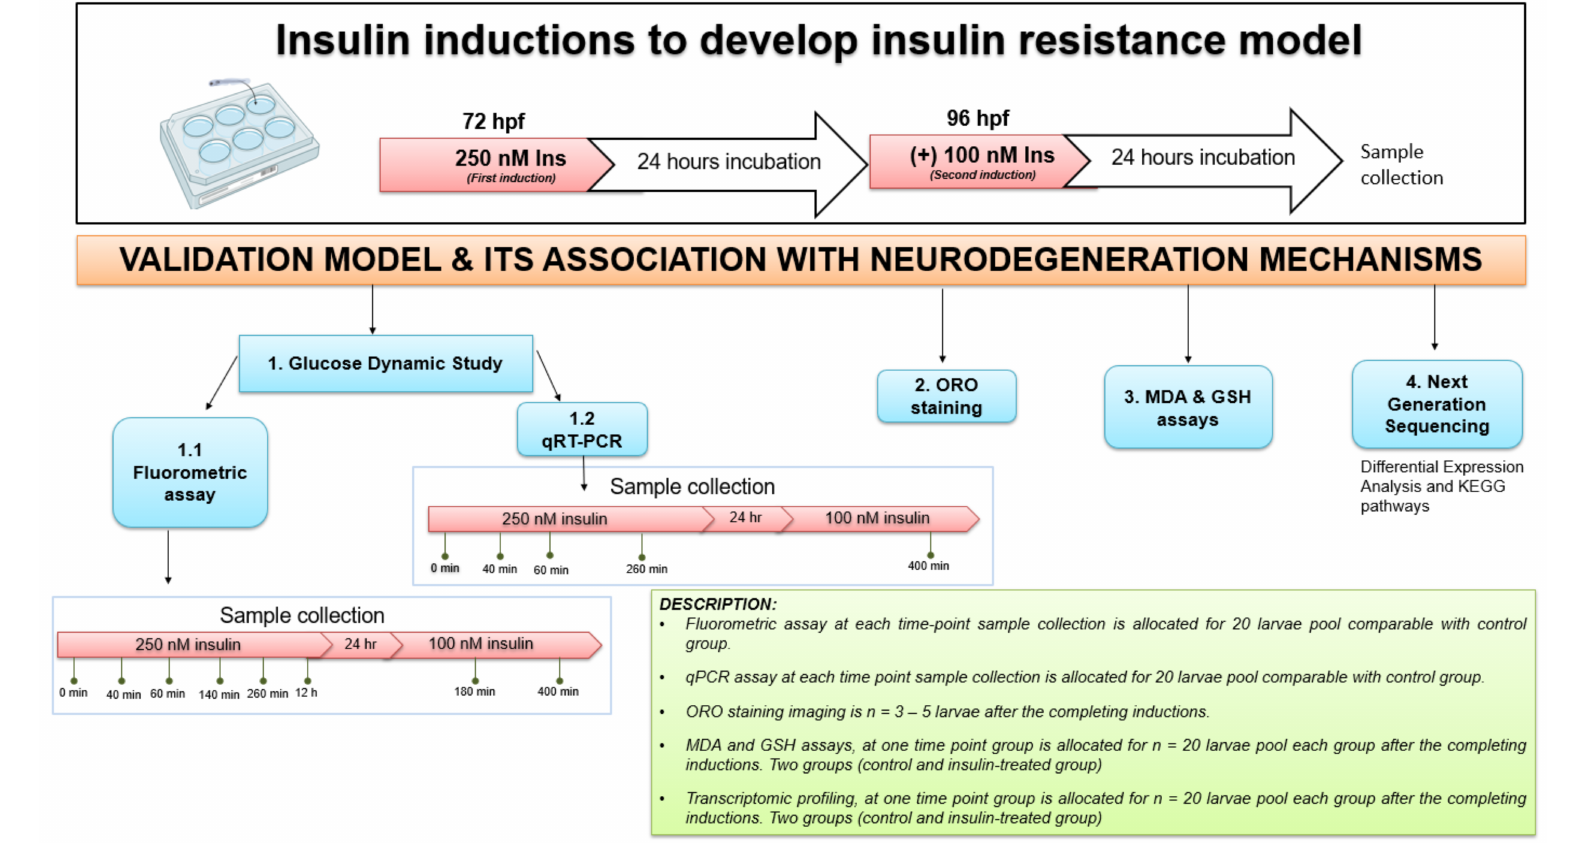
Figure 6. The experimental design for insulin resistance zebrafish larvae model at 72 and 96 hpf with 250 nM and 100 nM insulin induction, respectively, by immersion technique. The groups at each time point were assessed in triplicate ( n = 3). The variation in sampling timing after insulin immersion is revealed. Dynamic glucose assay samples for post-insulin immersion were collected at 0 min, 40 min, 60 min, 140 min, 260 min and 12 h at first induction of 250 nM insulin. After the second insulin induction of 100 nM insulin, samples were taken at 180 and 400 min. Quantitative RT-PCR (qRT-PCR) analysis samples were collected at 40, 60 and 260 min of 250 nM insulin induction and at 400 min of 100 nM insulin induction. After each insulin induction, the ORO staining was scored at 96 hpf and 120 hpf after the first and second insulin induction. MDA, GSH and next-generation sequencing (NGS) for transcriptome profiling were developed to connect to the mechanisms of neurodegeneration. The control used was E3 medium containing zebrafish buffer. hour-post-fertilization (hpf) ; Insulin (Ins)